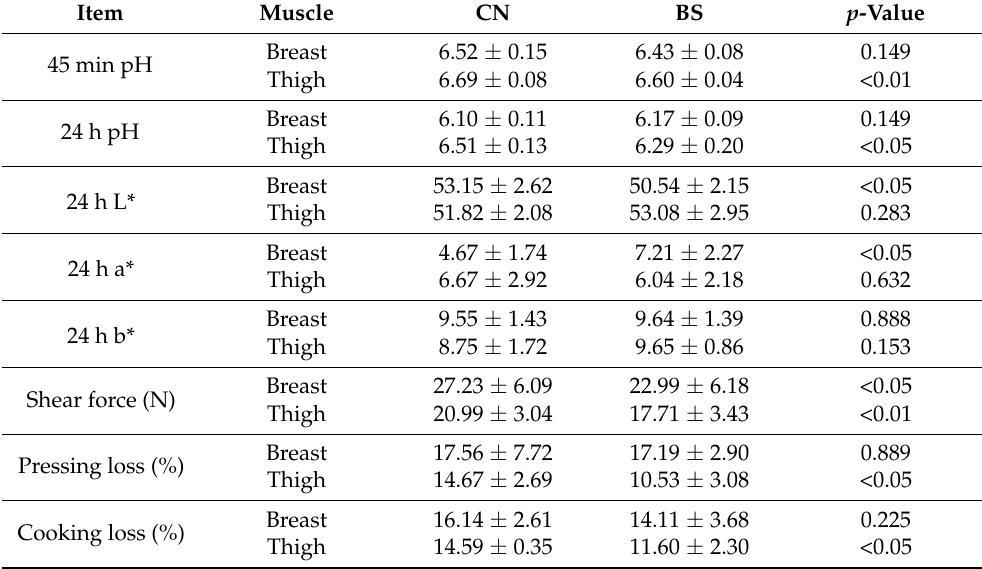
Table 4. Effects of dietary Brevibacillus laterosporus S62-9 on the meat quality of chicken meat. Item Muscle